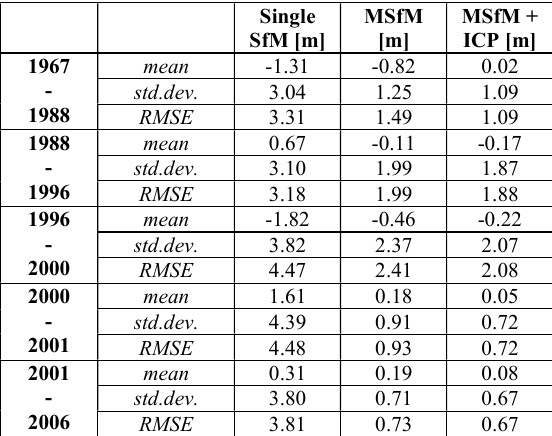
Table 4. Statistics after comparison of points in stable areas according to three different approaches: single SfM based on independent GCPs per each dataset (Malekian et al., 2023); MSfM with GCPs from Dataset 2000; MSfM followed by ICP